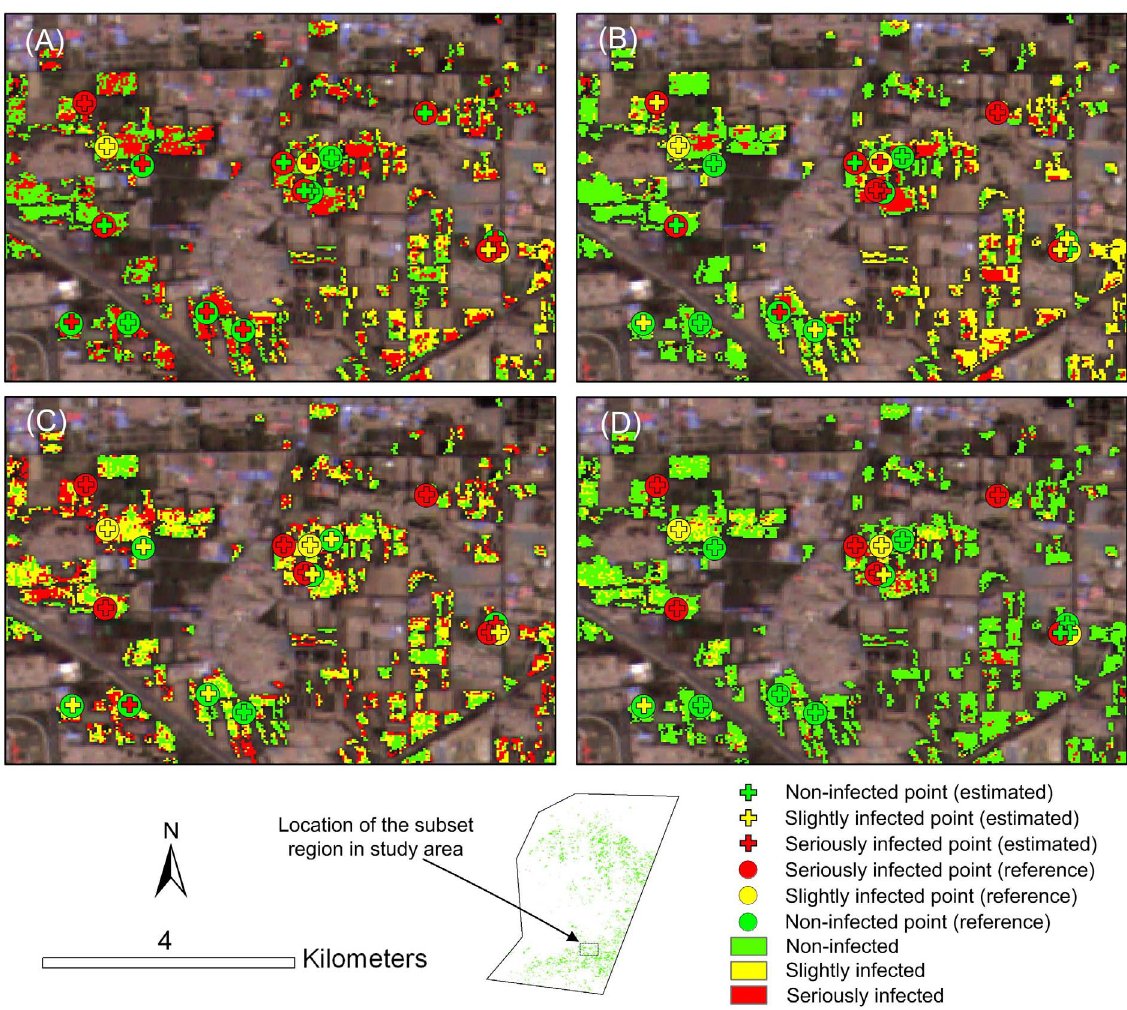
Figure 8. Infection map of powdery mildew in a subarea produced by MD (A), MLC (B), PLSR (C) and MTMF (D).